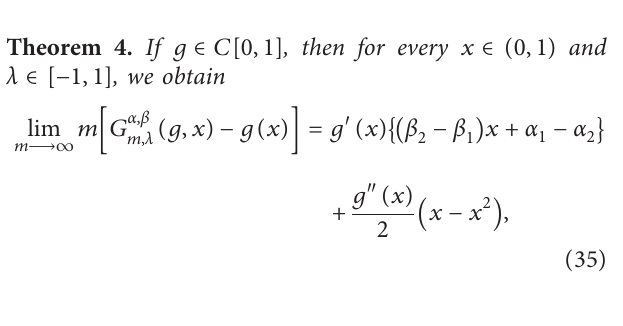
Figure 2: Convergence of G 1 , 2